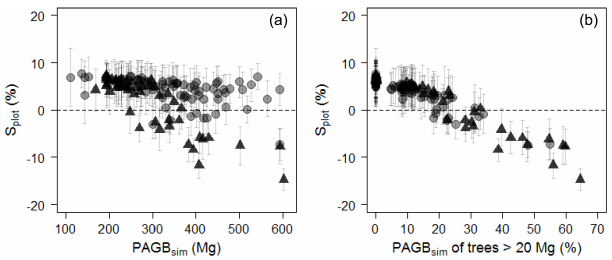
Figure B1. Plot-level propagation of individual-level model error. Panel (a) : mean relative error ( S plot , in %) and standard deviation of 1000 random error sampling against simulated plot AGB and (b) against the fraction (%) of simulated plot AGB accounted for by trees >20Mg. Plots from the Korup permanent plot are represented by triangles.